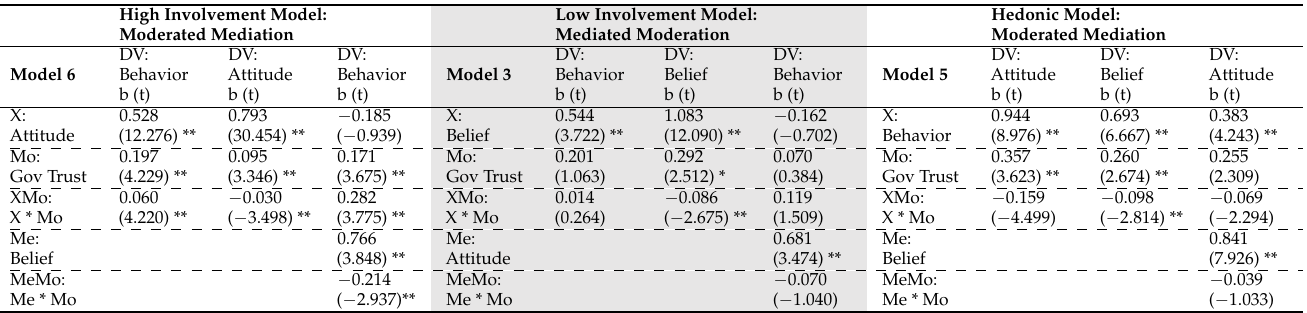
Table 6. Government Trust Model in